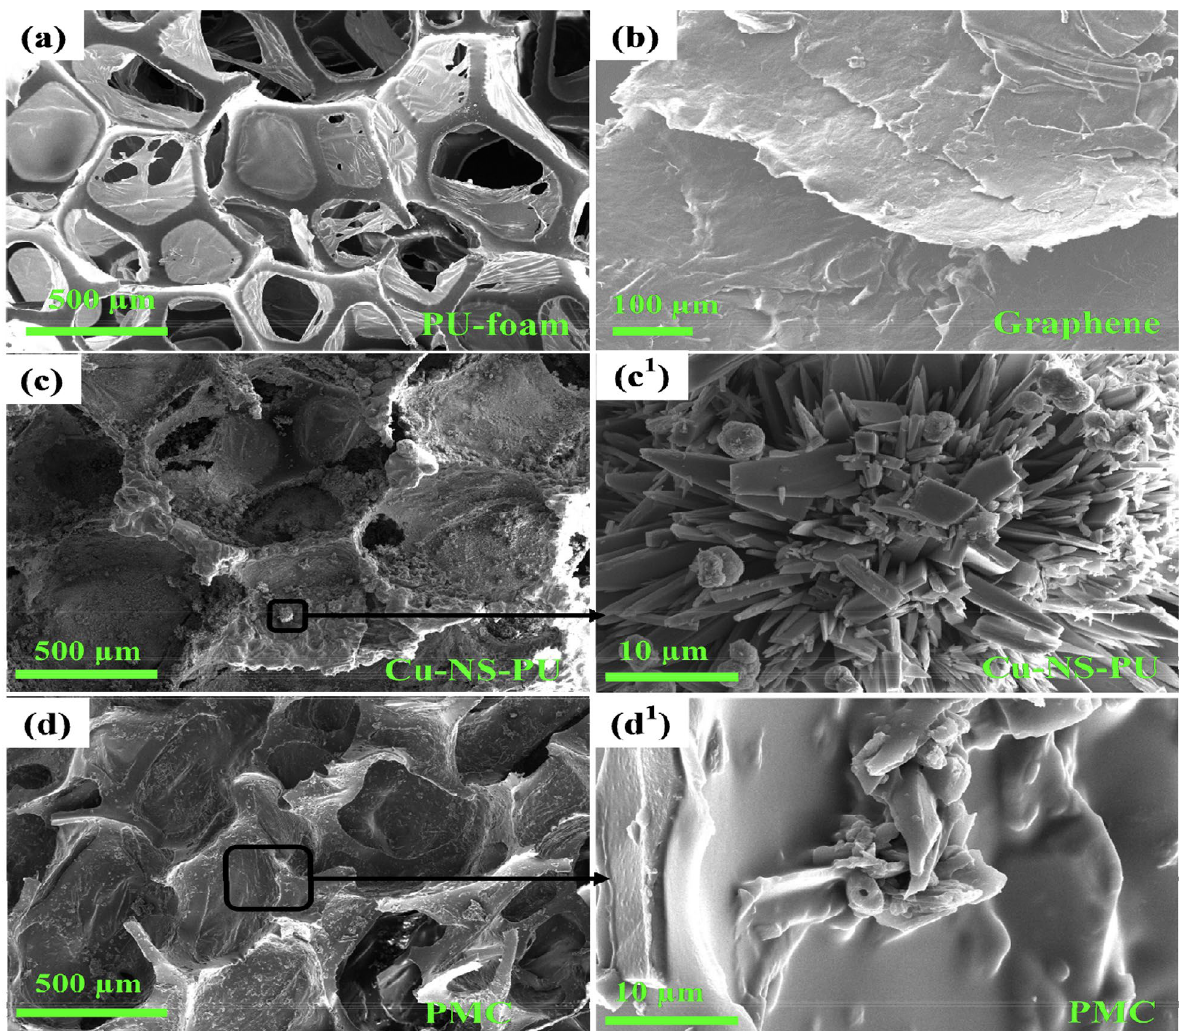
Figure 2. SEM images of ( a ) PU foam, ( b ) graphene nanosheet, ( c , c ’) Cu-NS-PU, and ( d , d ’)